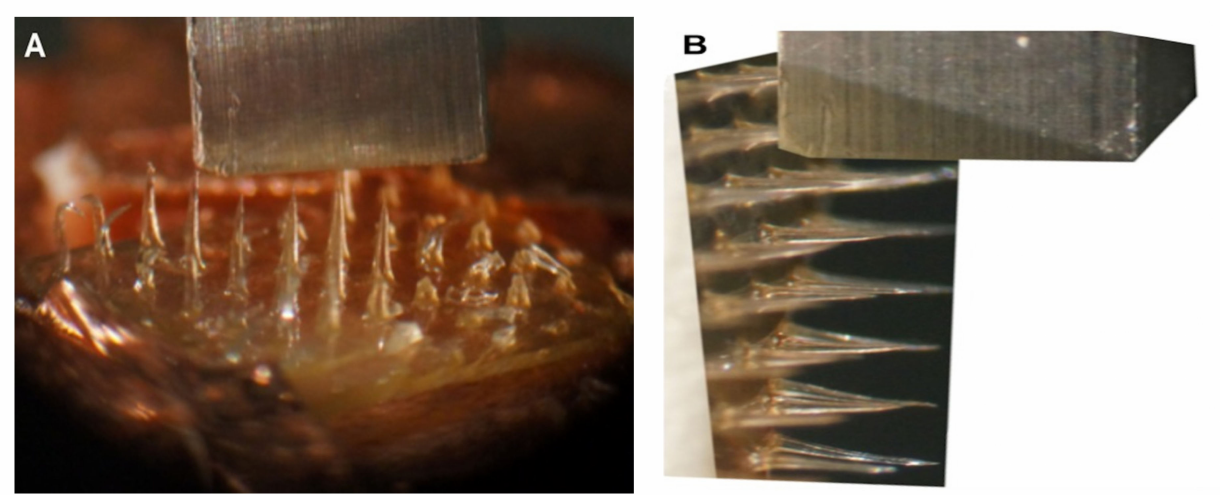
Figure 16. ( A ) Digital photograph of SA MN pressed against the metal mill during axial fracture force measurement with the micromechanical tester (Instron ® Model 5969; Instron, Norwood, MA). ( B ) MN shafts were transversely pressed against the metal mill for measurement of the transverse fracture force by way of the micromechanical tester (Instron ® Model 5969, Instron, Norwood, MA) [80]. Reproduced with permission from Demir et al., Characterization of Polymeric MN Arrays for Transdermal Drug Delivery; published by PLoS One,